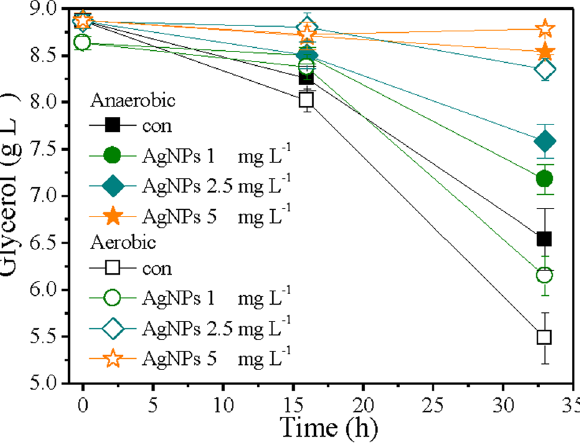
Figure 3. Variations of glycerol concentration in P. aeruginosa cultures in the presence of different levels of AgNPs under anaerobic versus aerobic conditions.